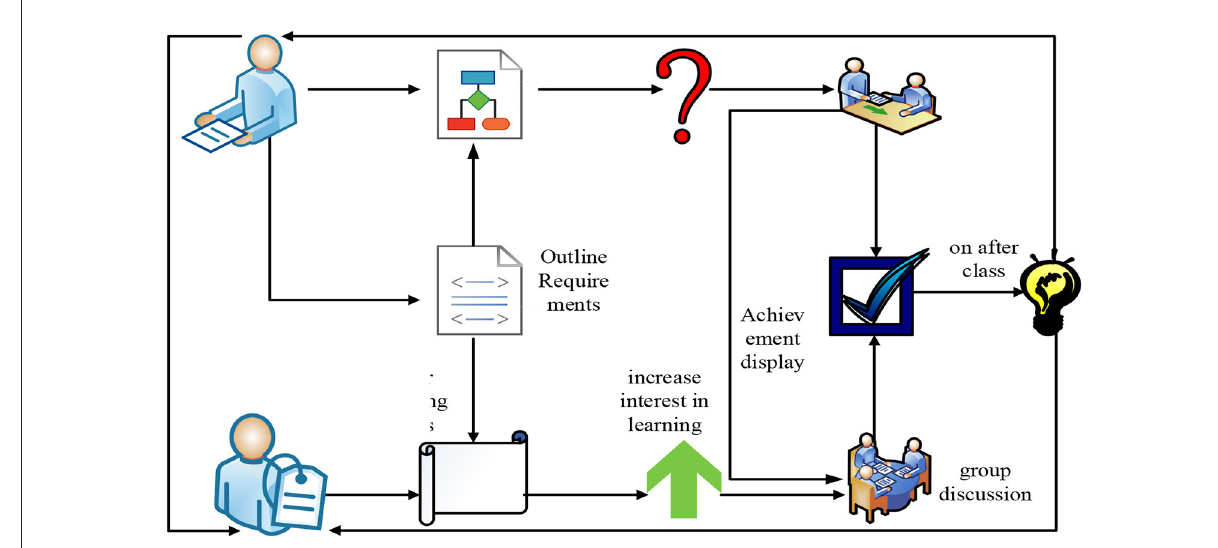
FIGURE5 Self-learning classroom history called mode implementation